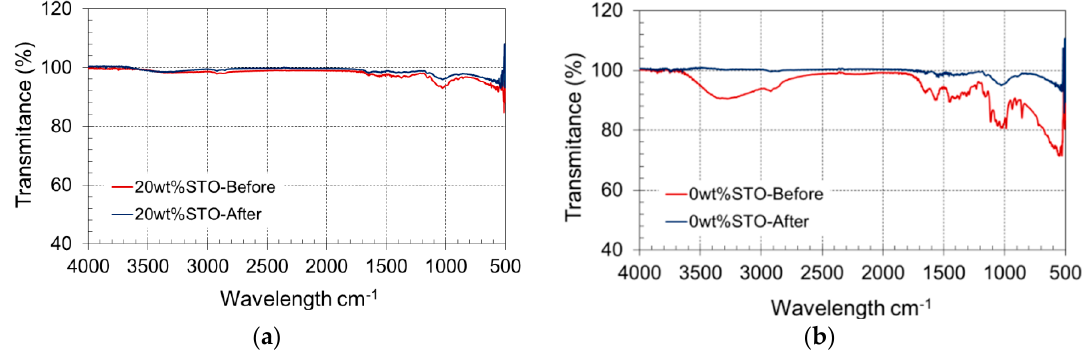
Figure 11. ( a ) Fourier transform infrared spectra for bio-composites made of 25 v% of cellulose exposed to HCl solution with 0 wt. % STO; ( b ) 20 wt. %.